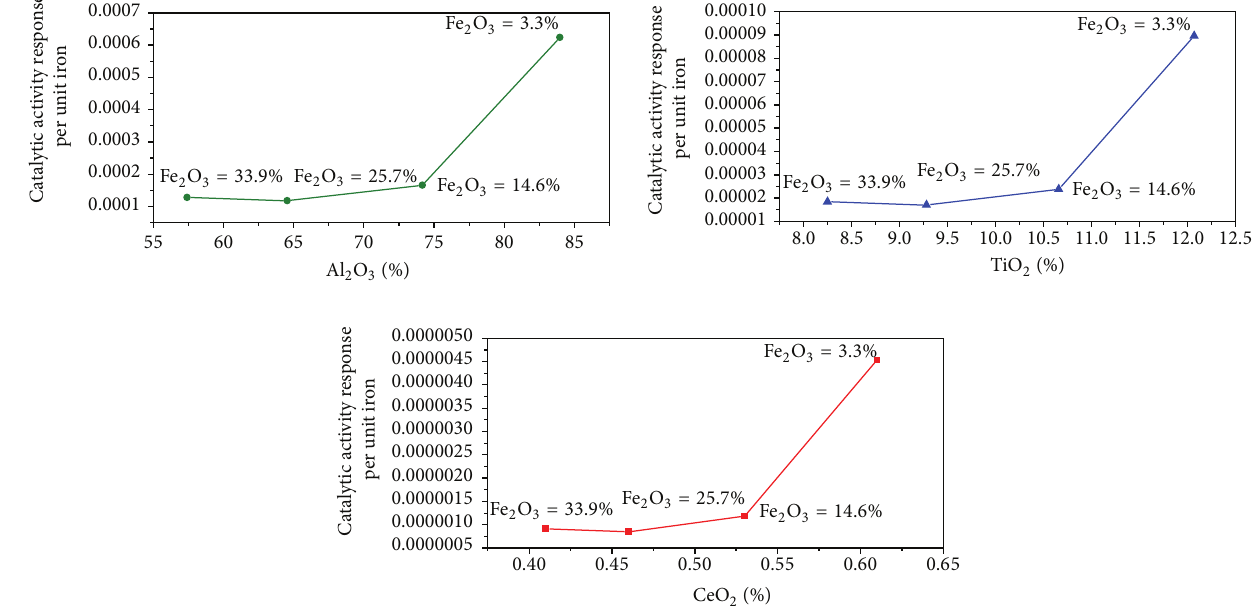
Figure 12: Effect of % composition of CeO 2 , TiO 2 , and Al 2 O 3 on the catalytic activity per unite iron oxide.